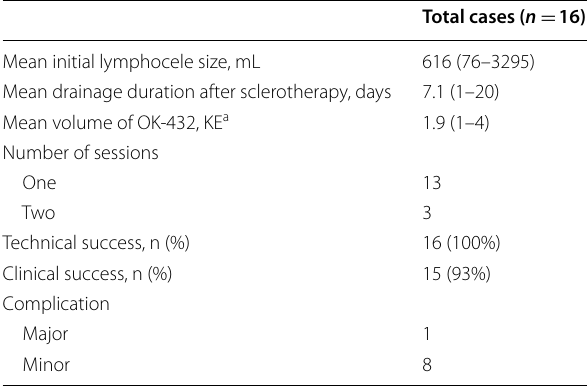
Table 2 Results of percutaneous sclerotherapy Table 3 Cases of